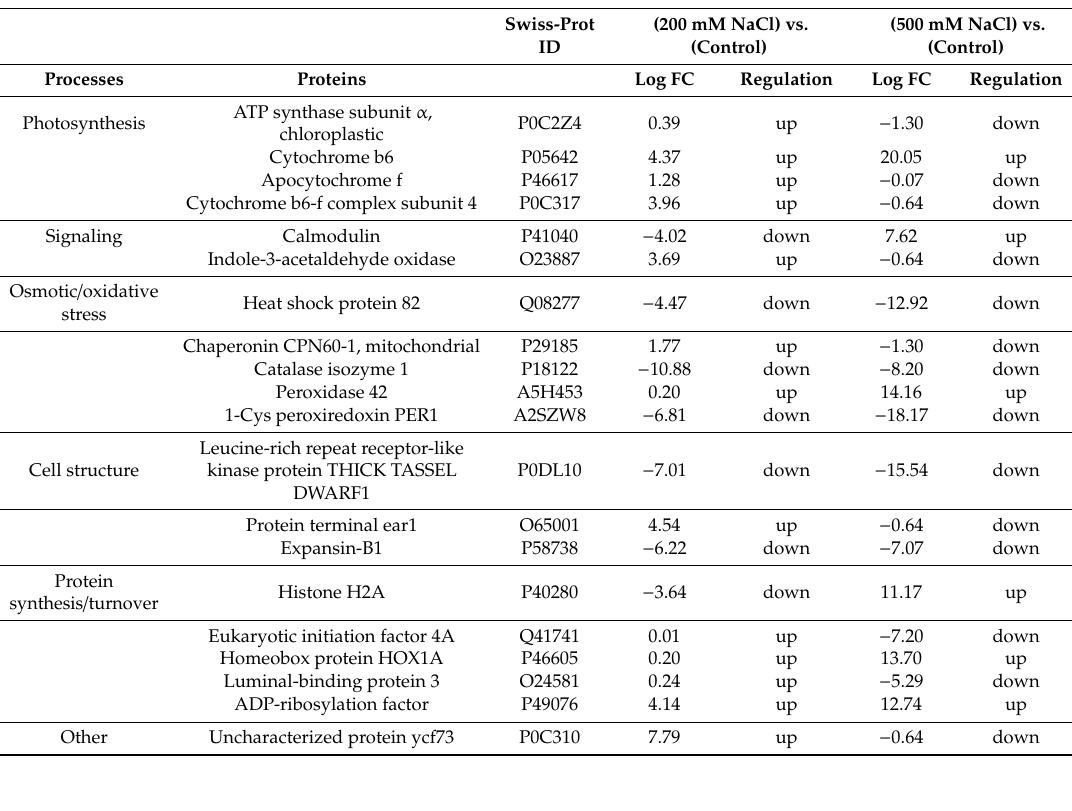
Table 1. Discriminant proteins in Salicornia brachiata shoots under either 200 mM and 500 mM NaCl salinity, together with fold-change (FC) values and regulation.